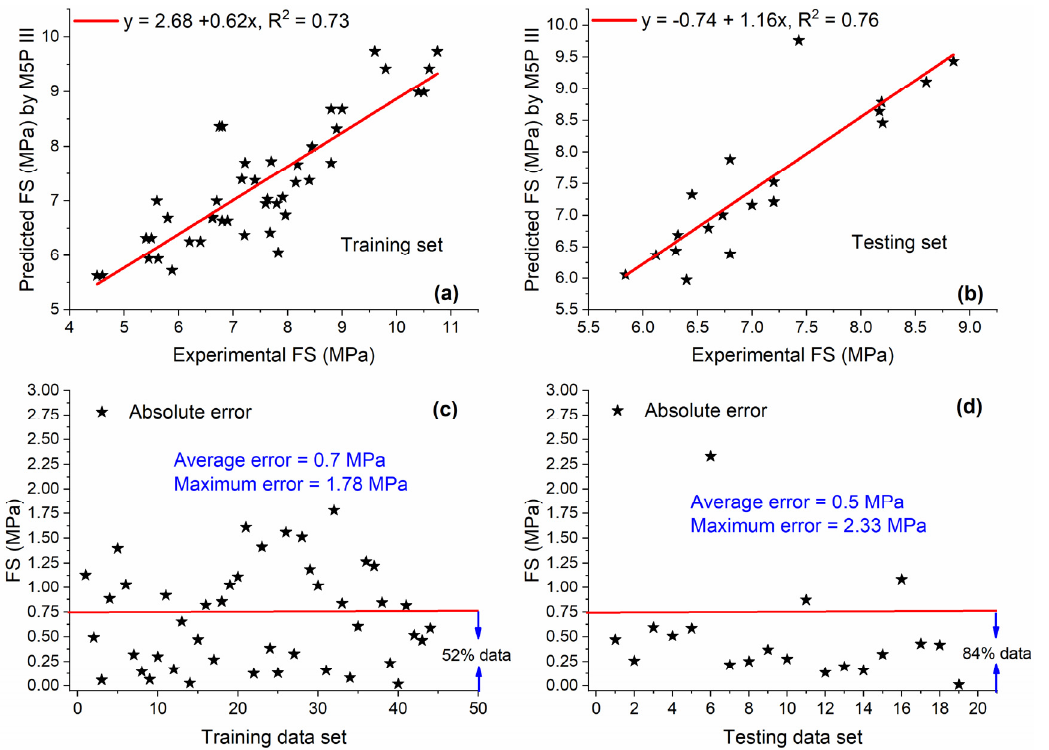
Figure 21. Experimental and predicted values of FS by M5P III for ( a ) training set and ( b ) testing set, and their corresponding absolute error for ( c ) training data set and ( d ) testing data set.